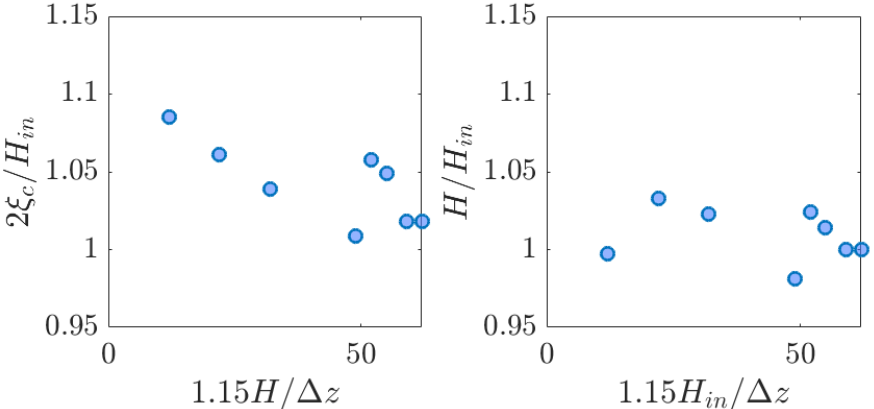
Figure A1. Mesh study performed to find the grid that can be used for simulating the problem. Left and right panels respectively show the recorded wave crest height and wave height. The results presented in this figure correspond to water waves with a period of 0.8 s and a wave height of 0.035 m.